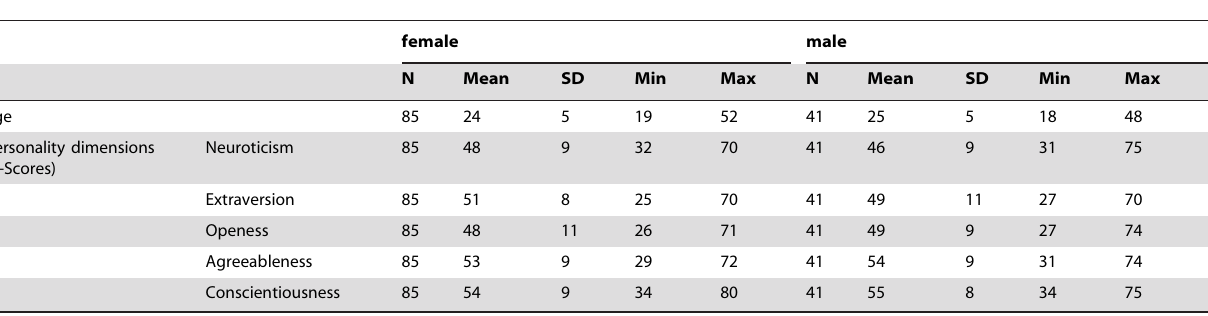
Table 1. Participant’s demographic